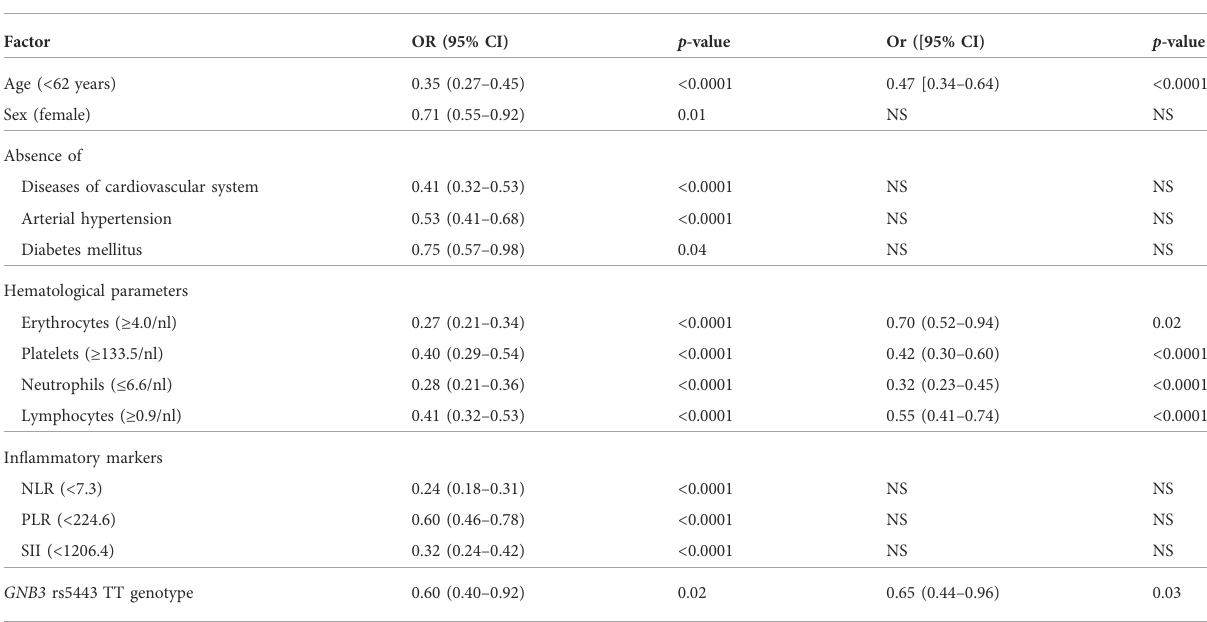
TABLE 3 Protective factors against COVID-19 fatality. Abbreviations: nl = nanoliter; NLR = neutrophil-lymphocyte ratio; PLR = platelet-lymphocyte ratio;SII=systemicimmune-in fl ammationindex;OR=oddsratio;CI=con fi denceinterval,NS=notsigni fi